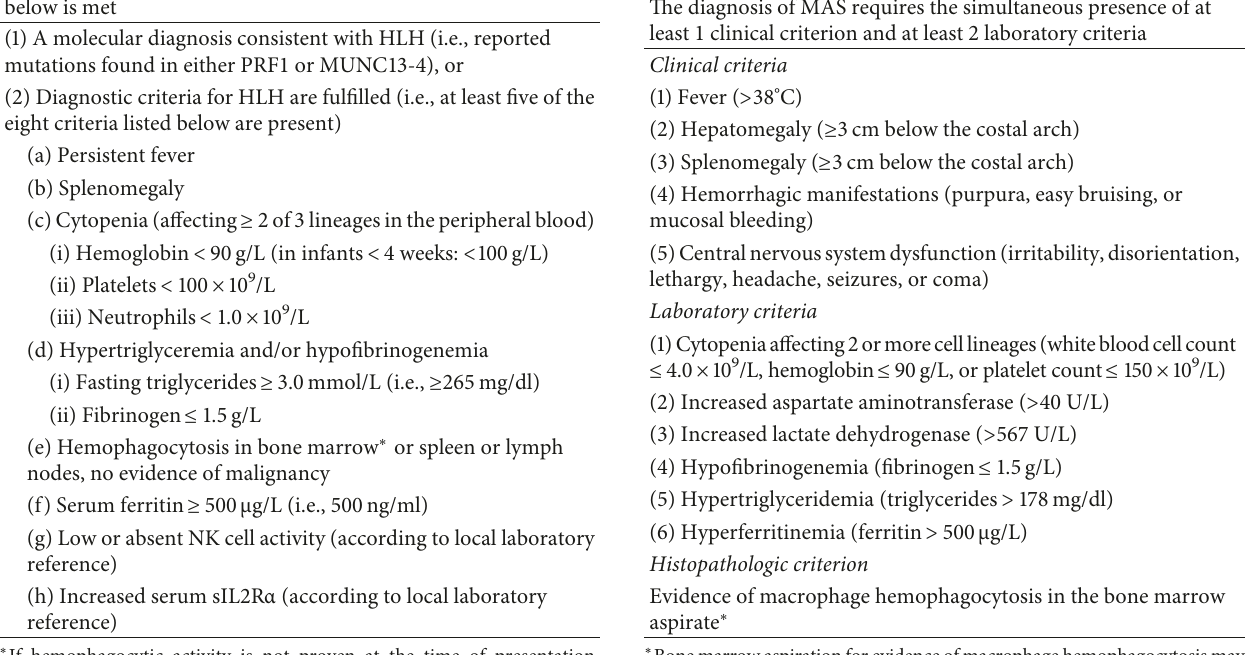
Table 2: Diagnostic criteria for macrophage activation syndrome: Parodi’s preliminary diagnostic guidelines for MAS as a compli- cation of juvenile